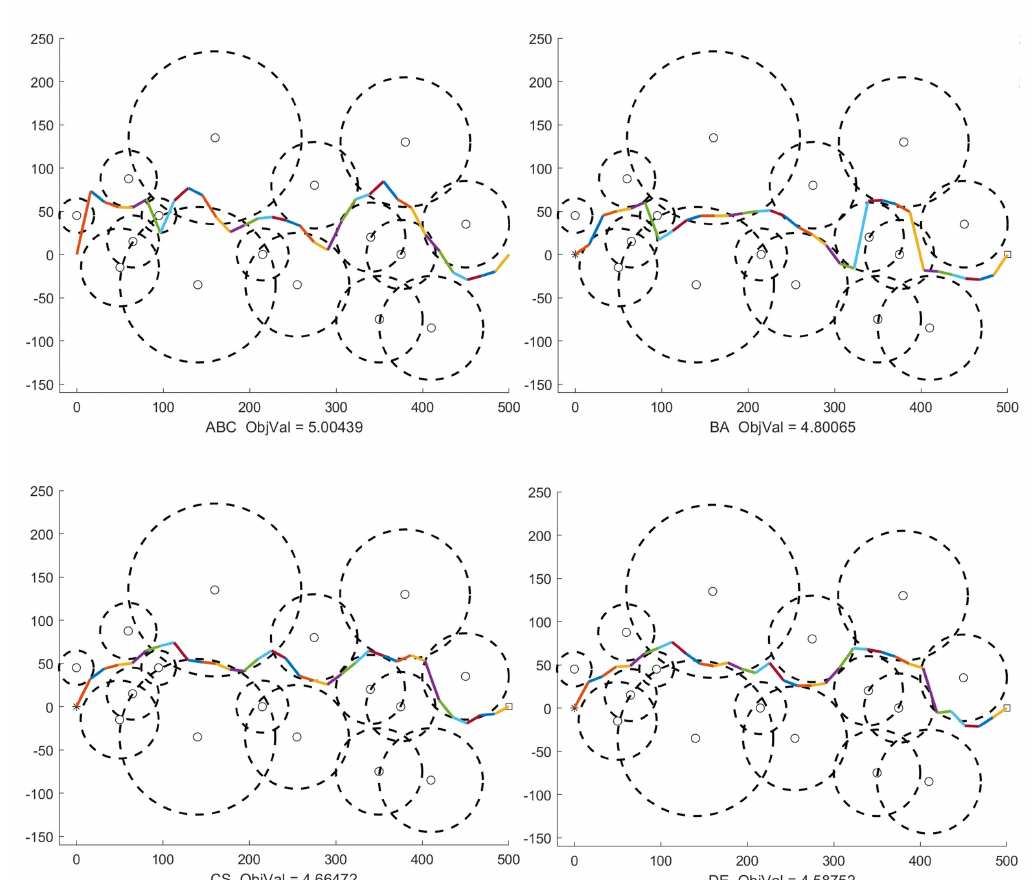
Figure 6. The comparison performance of different swarm intelligence algorithms including ABC, BA, CS and DE for Case 8 with D = 30, N =